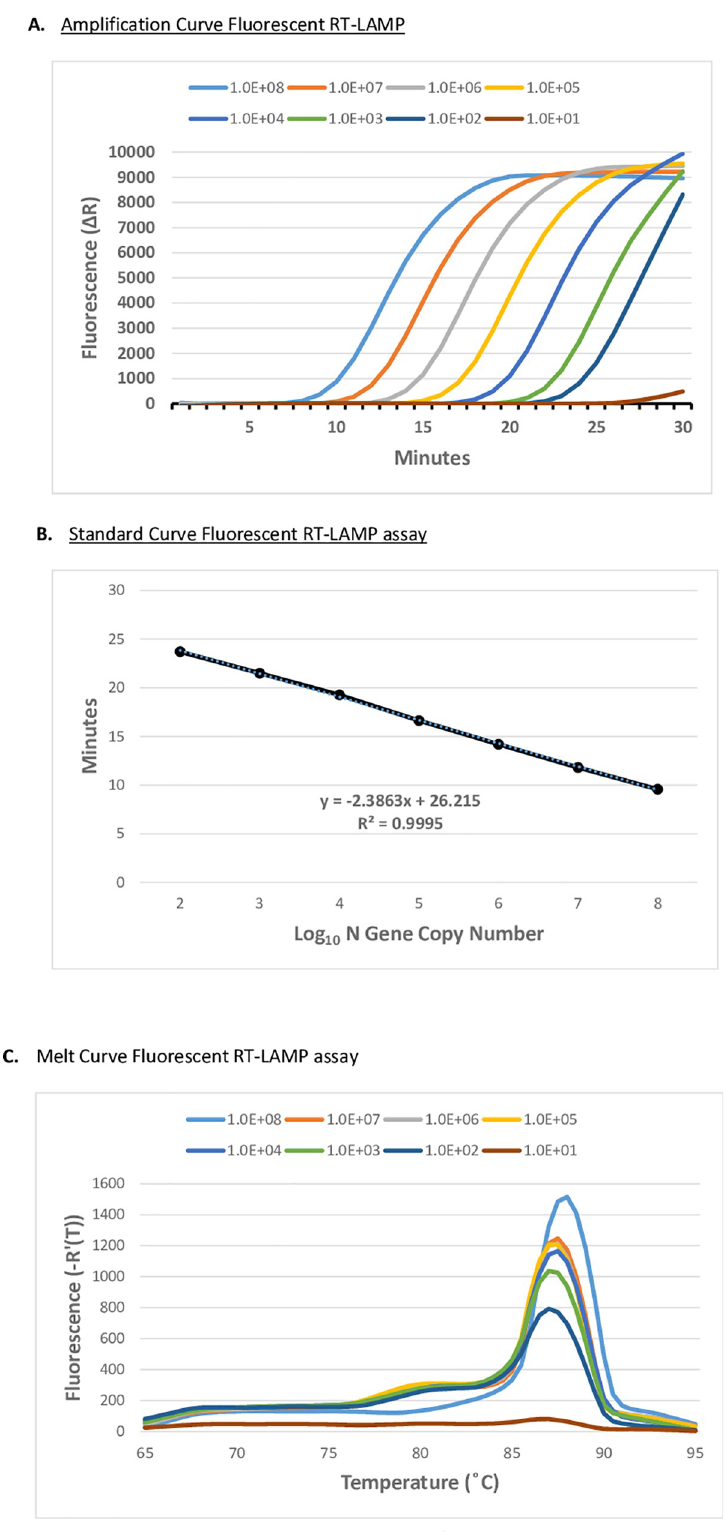
Fig 2. SARS-CoV-2 fluorescent RT-LAMP assay. A. Fluorescent RT-LAMP assay targeting SARS-CoV-2 Wuhan- Hu-1 N gene IVT (GenBank: MN908947) RNA. Log-dilution series of N gene IVT RNA ranging from 10 8 to 10